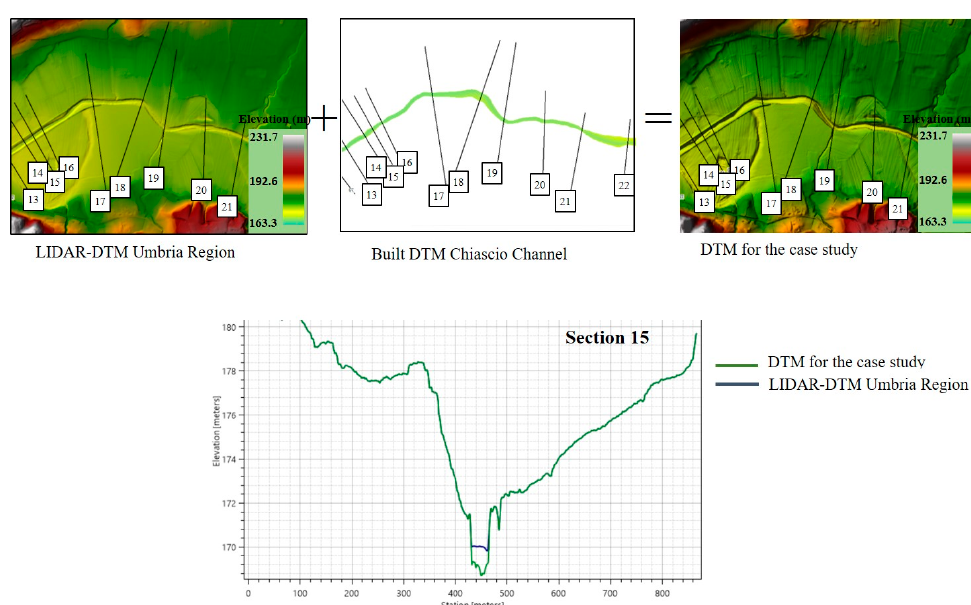
Figure 5. Construction scheme of the detailed terrain model.